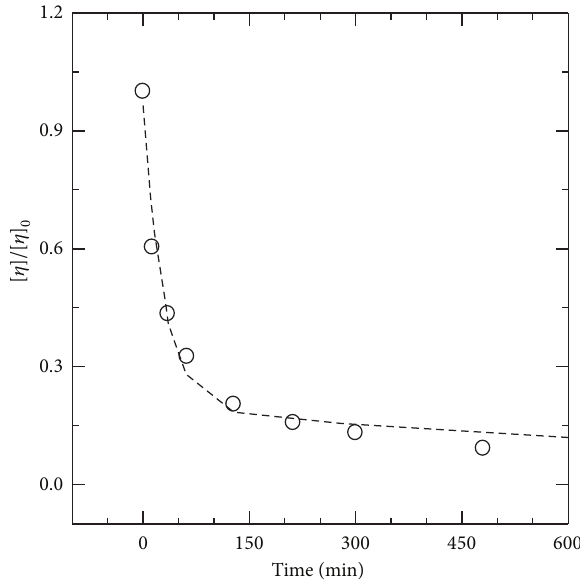
Figure 3: The normalized intrinsic viscosity of chitosan fragments, ]/[𝜂 ] , as a function of reaction time (0–300min) for frag- [𝜂 𝑡 0 mentation of chitosan solution (1.0% w/v) by 0.5 N HCl at 65 ∘ C. Open circle for experimental point and dotted line for curve fit. The reaction was performed at 65 ∘ C, and intrinsic viscosity was measured at 25 ∘ C.